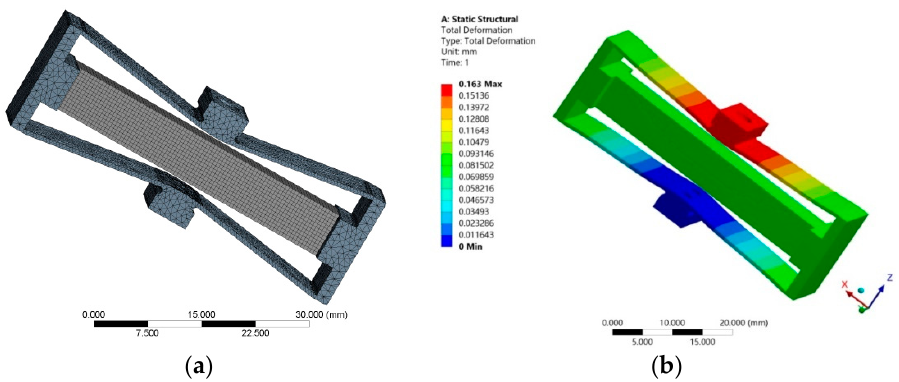
Figure 6. Finite element simulation of displacement amplification mechanism. ( a ) Mesh generation; ( b ) Deformation nephogram. ( b ) Deformation